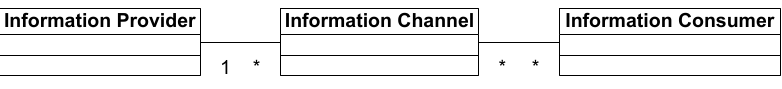
Figure 3. Relationships between the information provider, information channel (in the IIP) and information